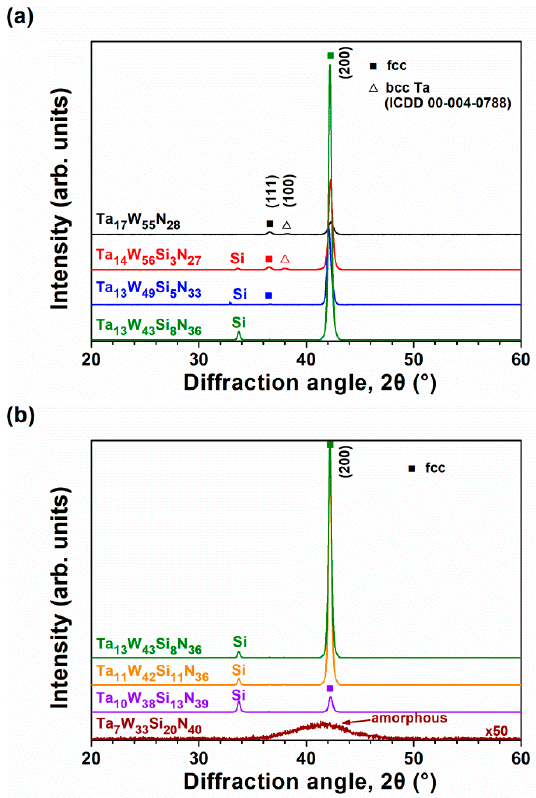
Figure 7. BBXRD patterns of ( a ) Batch S and ( b ) Batch T TaWSiN films.